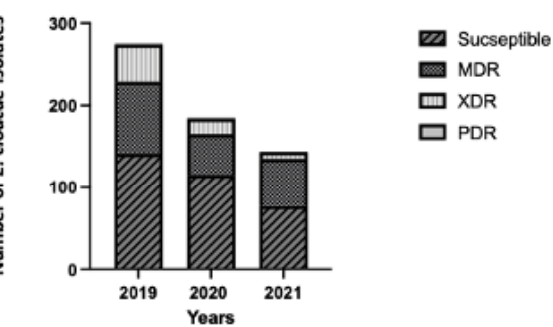
Table 1. Comparison of the demographic and clinical characteristics of ICU patients infected with E. cloacae